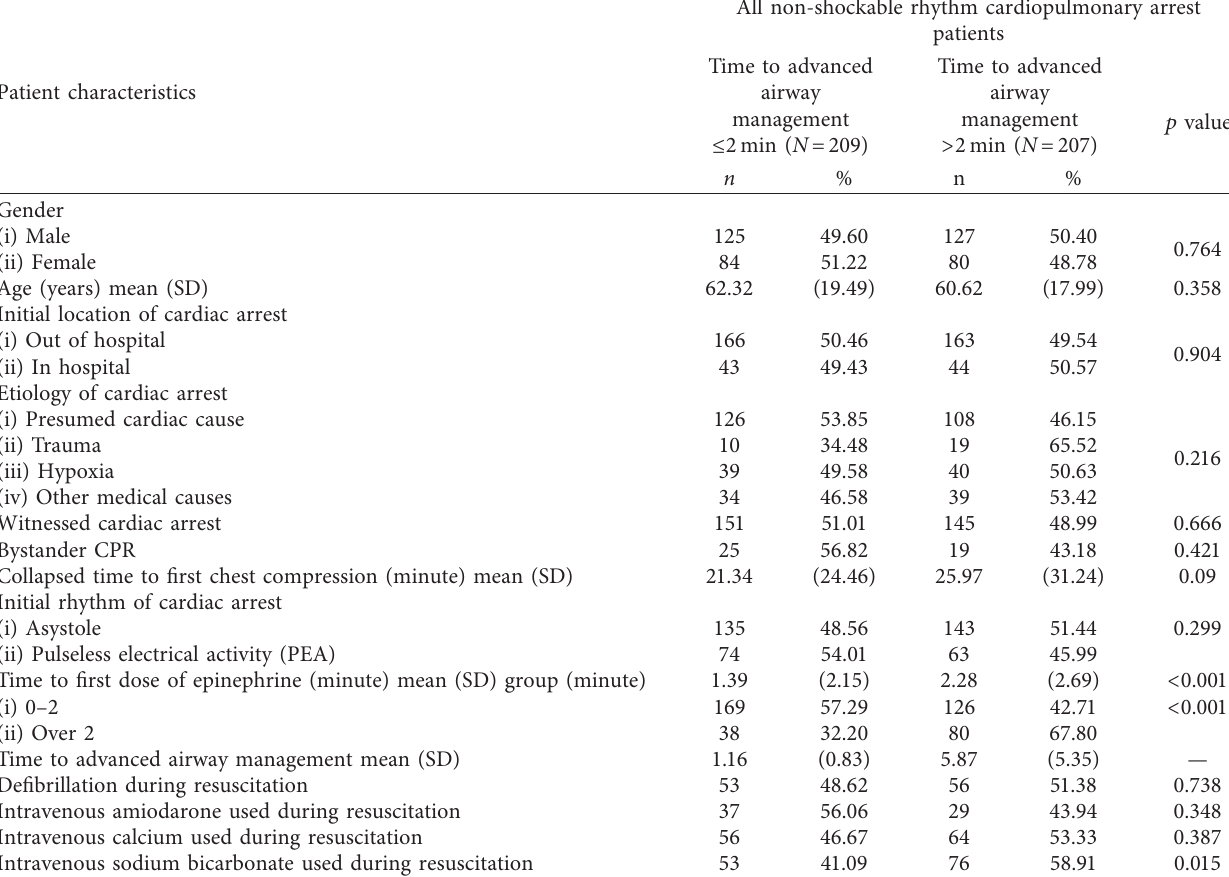
Table 1: Study population characteristics.